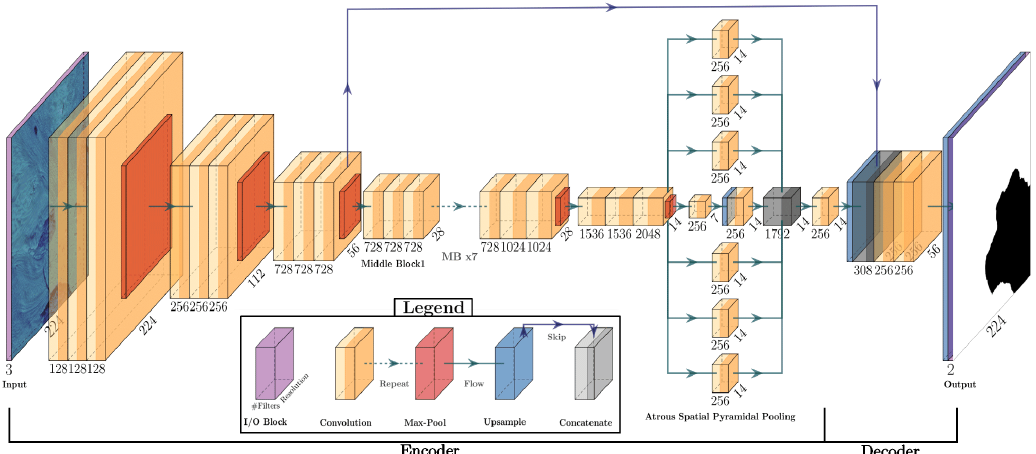
Figure 5. The CALFIN-NN processing architecture. Each orange “Xception” block consists of convolution kernels that detect features in the previous block. Blocks are reduced in size periodically to pool increasingly complex and numerous feature maps. U-shaped connections help refine the probability masks during up-sampling. Note that the seven repeated Xception blocks in the middle section are omitted for